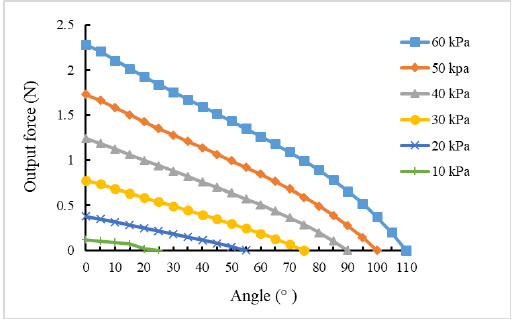
Figure 12. Relationship between the end-output force and the bending angle.